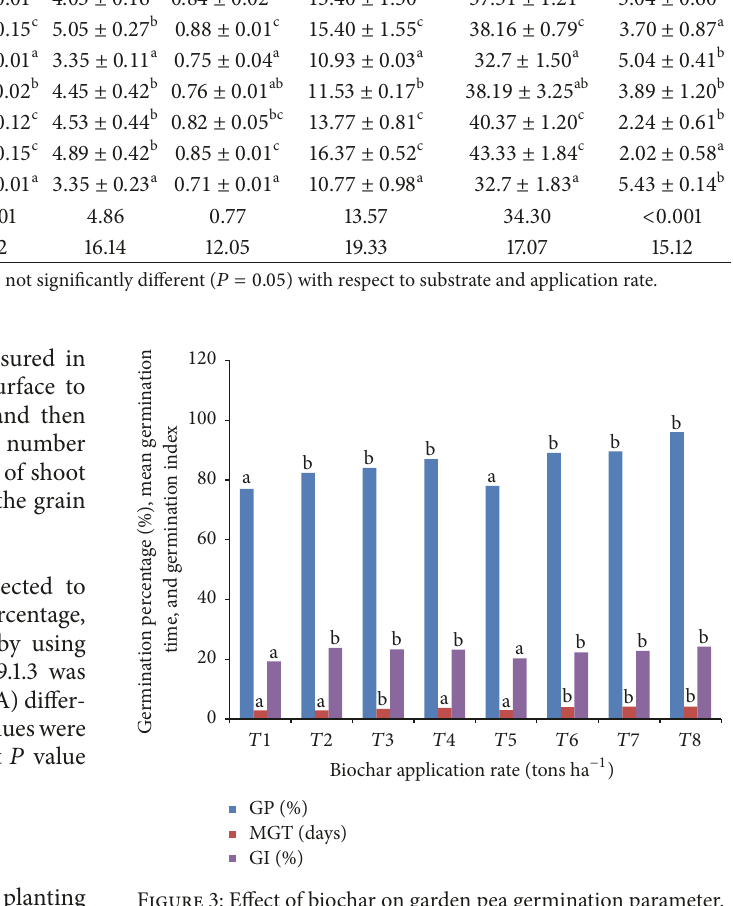
Figure 3: Effect of biochar on garden pea germination